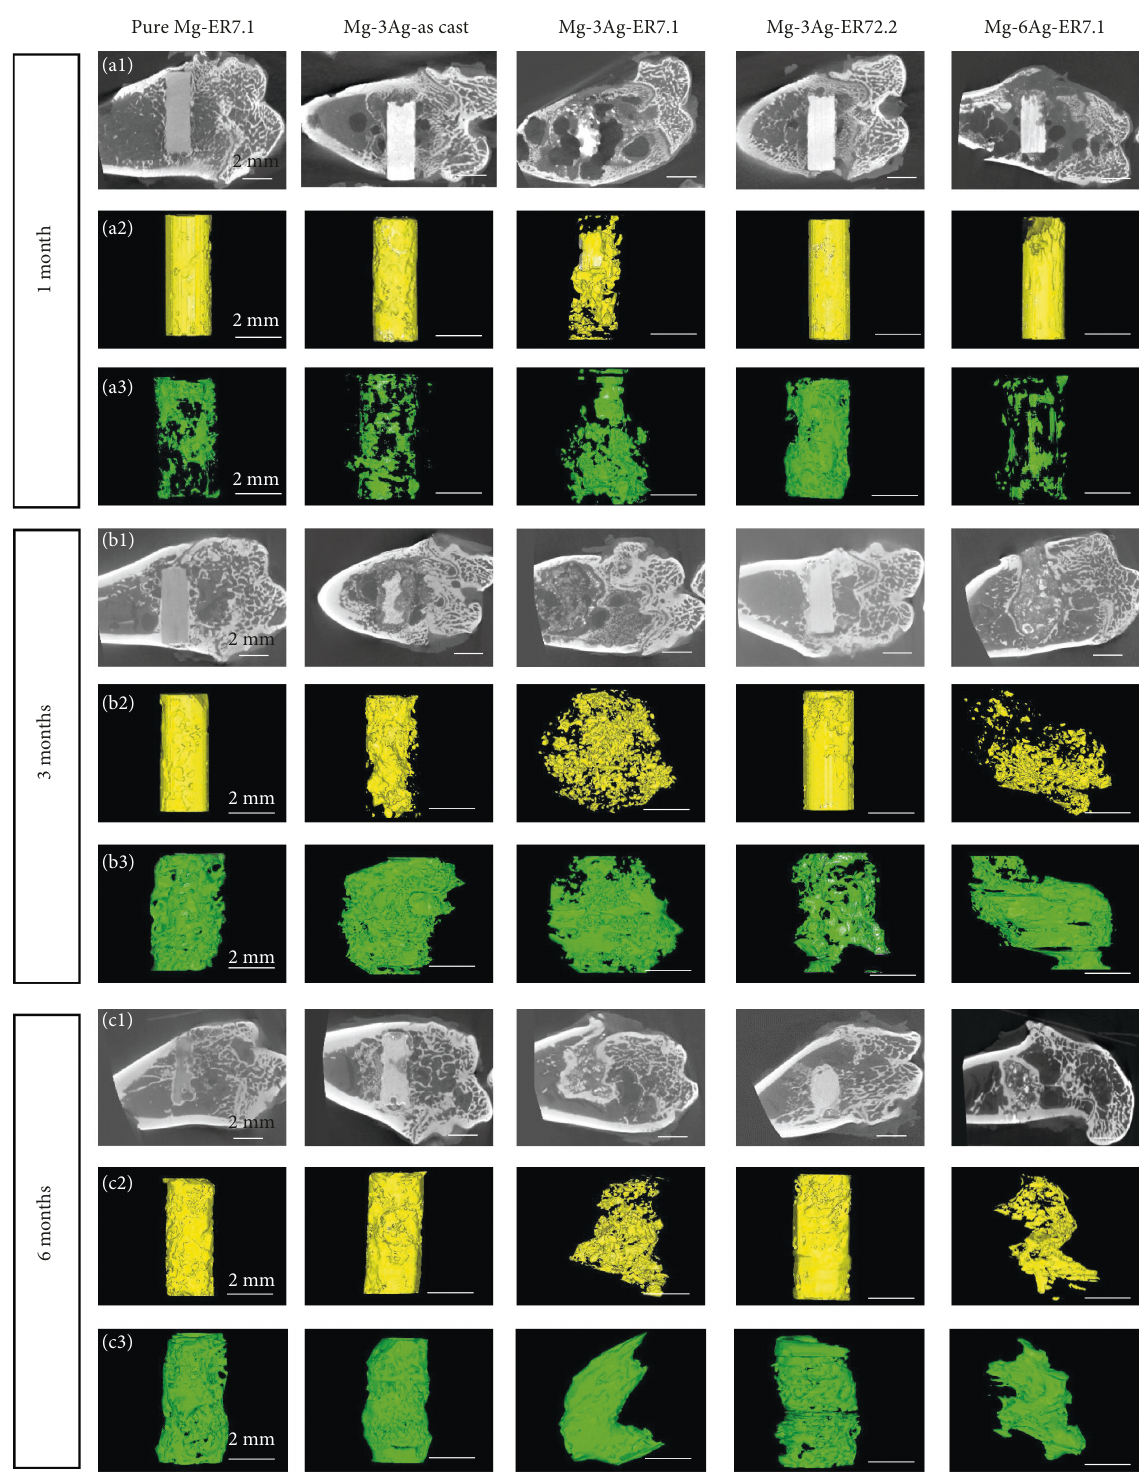
Figure 11: Micro-CTscans for (a 1 , b 1 , c 1 ) two-dimensional slices and three-dimensional reconstructed images of (a 2 , b 2 , c 2 ) implants and (a 3 , b 3 , c 3 ) new bone after 1, 3, and 6 months of The pure Mg-ER7.1 implant degraded steadily with time, and 6 months after surgery. To quantitatively determine the with few hydrogen gas bubbles appearing. The new bone degradation behavior and the new bone growth, the volume volume increased as degradation proceeded, with no ab- remaining and the BV/TV were calculated and presented in normal signs of osteolysis, deformity, or dislocation. For Figure 12.